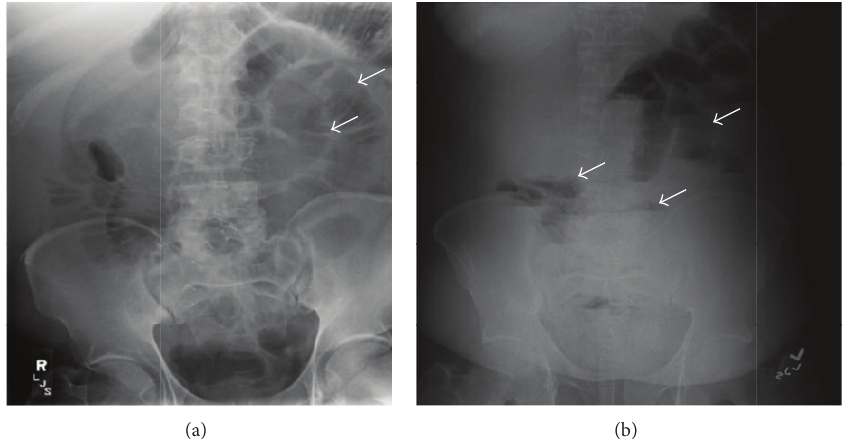
Figure 1: X-ray abdomen. (a) Supine abdominal radiograph shows dilated small bowel loops and absence or paucity of gas in the large bowel due to distal small bowel obstruction. (b) Upright abdominal radiograph shows multiple air-fluid levels in upper and central abdomen that represent dilated proximal and central fluid-filled small bowel due to distal small bowel obstruction (arrows).